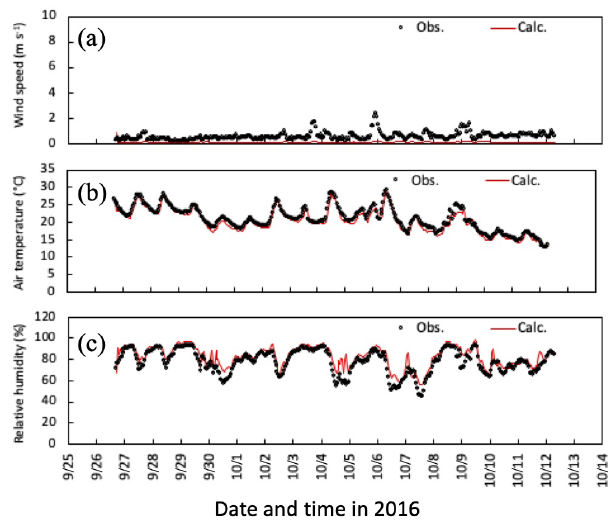
Figure 4. Temporal changes in observed and simulated (a) horizon- tal wind speed, (b) air temperature, and (c) relative humidity at 6m height from 27 September to 11 October 2016. Please note that the date is given on the x axis in the month/day format.